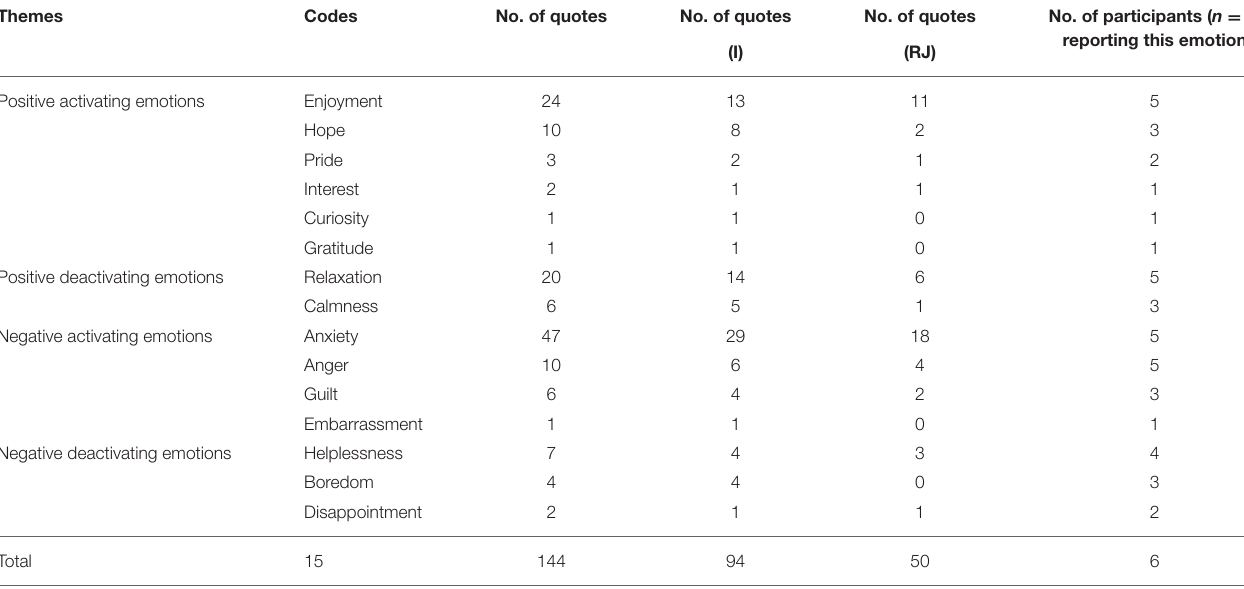
TABLE 4 | Frequency analysis of codes and quotes of the achievement emotions from semi-structured interviews and reflective journals.